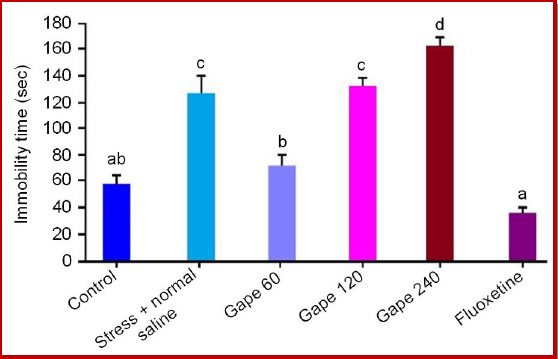
Figure 1: Effect of intraperitoneal injection of fluoxetine and different doses of grape seed oil on immobility time in tail